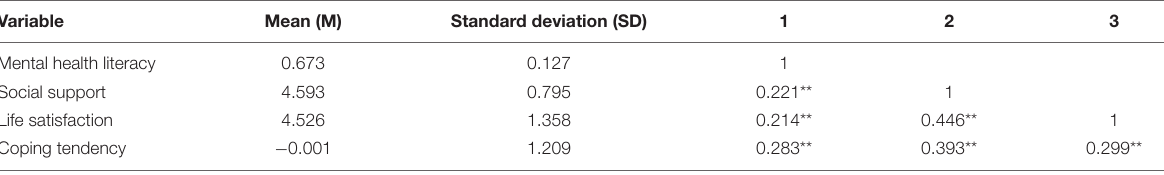
TABLE 1 | Descriptive statistics and correlation matrix for each variable.